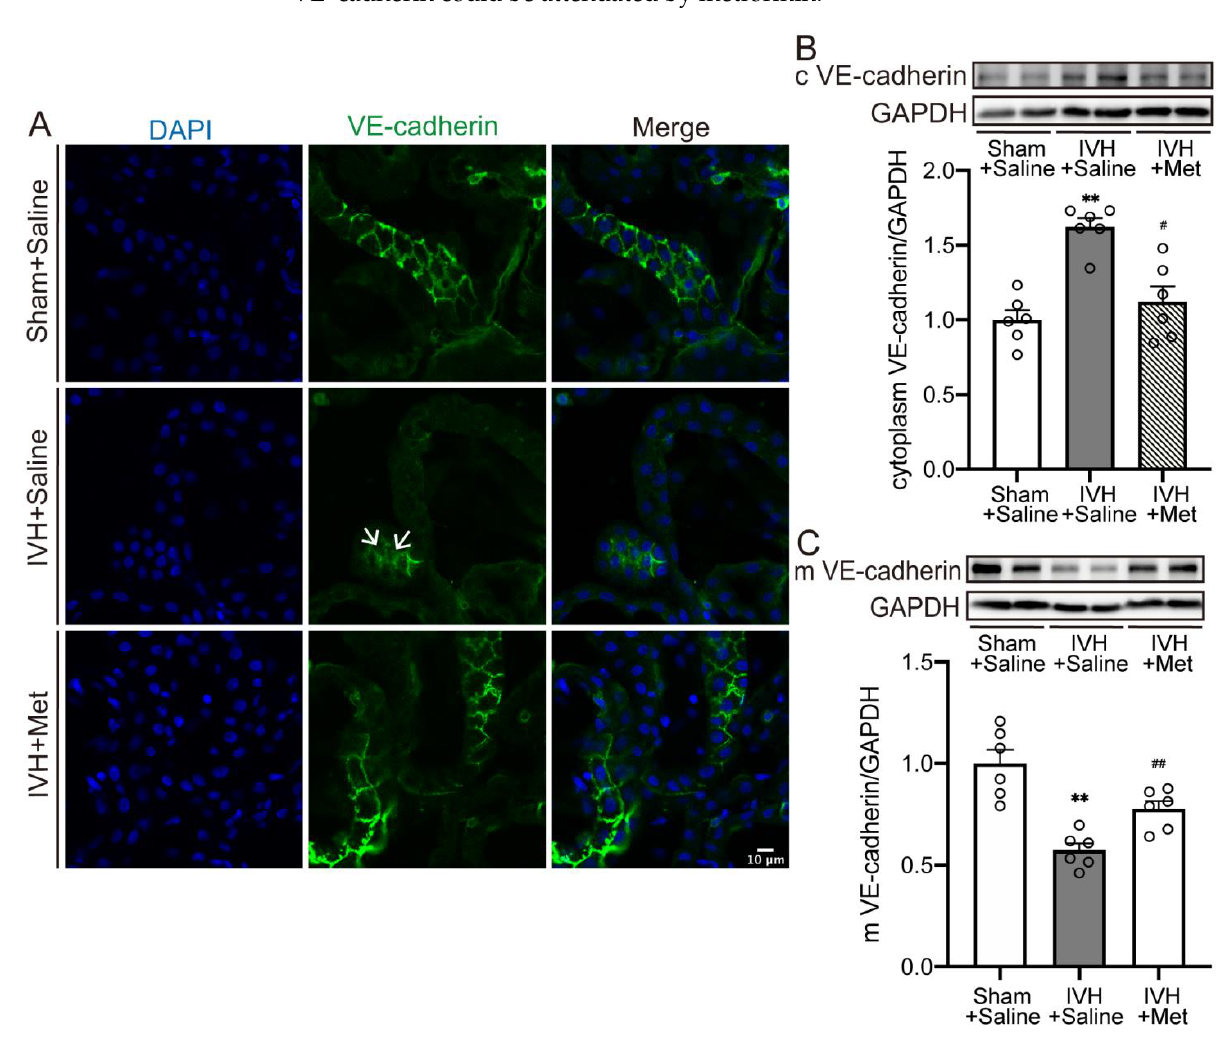
Figure 3. Metformin downregulated the internalization of VE – cadherin in choroid plexus after IVH ( A ) immunofluorescence staining of coronal sections showed the internalization of VE – cadherin, white arrow showed the intracellular fluorescent signal, n = 4, Scale bar = 10 μ m. ( B ) Western blot showed the VE – cadherin expression level in cytoplasm, n = 6. ( C ) Western blot showed the VE – cadherin expression level in membrane, n = 6. Data were analyzed by one-way ANOVA with a Tukey ’ s post hoc test. Values are means ± SEM, ** p < 0.01 vs. sham, # p < 0.05 vs. IVH + Saline, ## p < 0.01 vs. IVH + Saline.